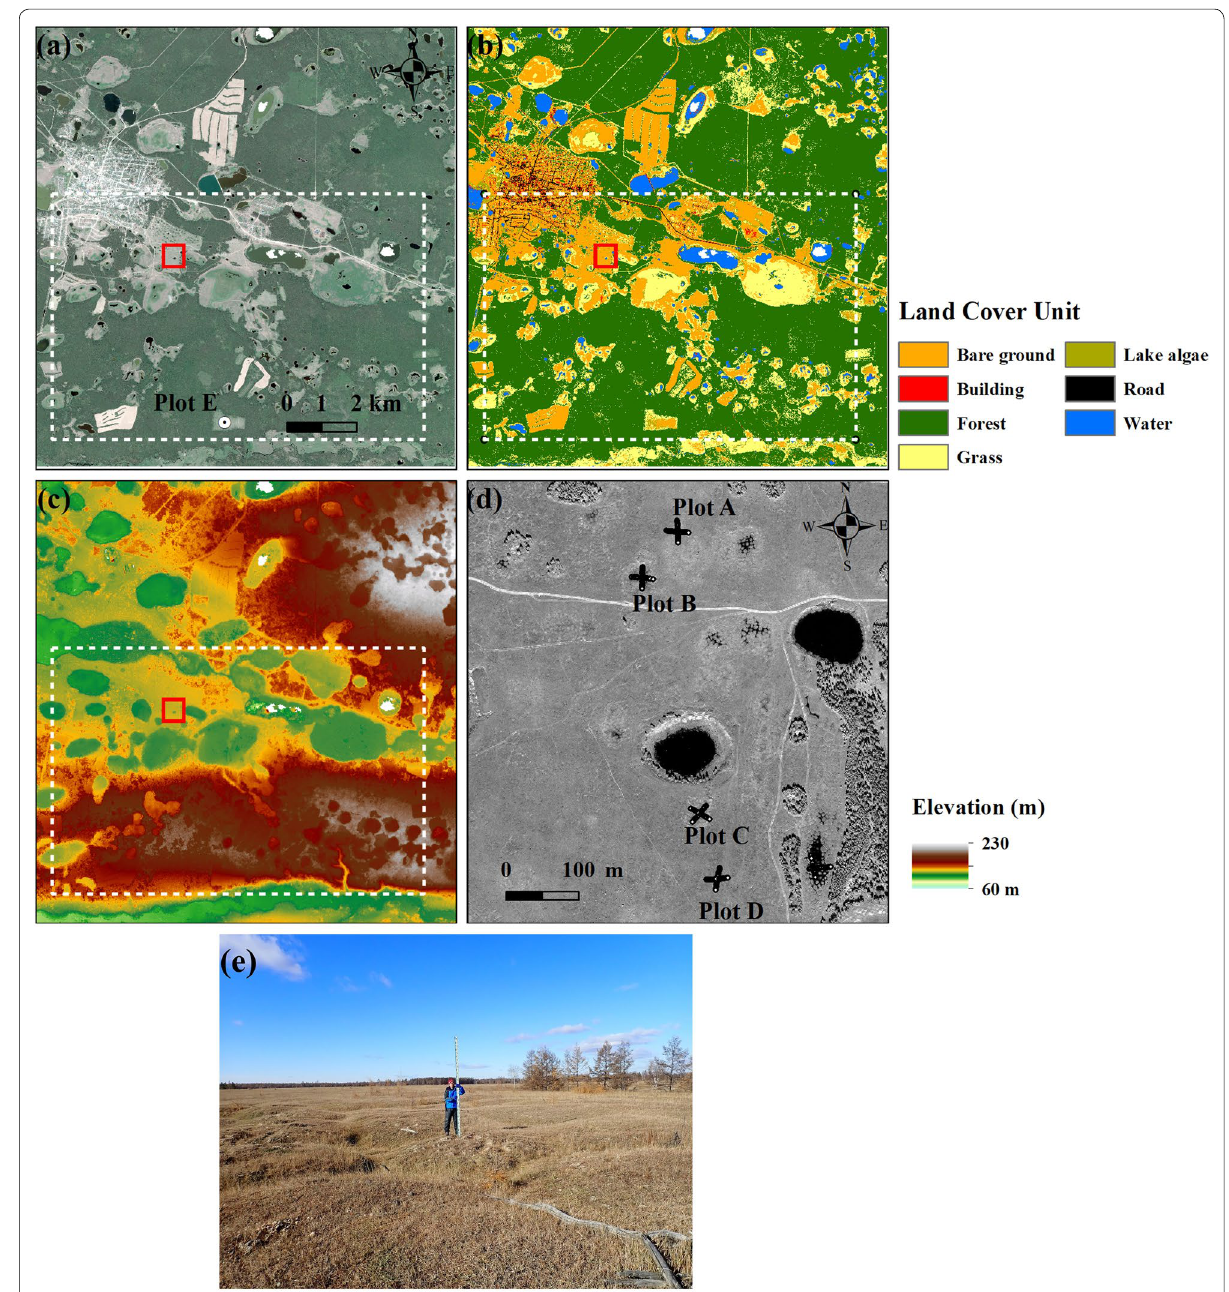
Fig. 2 a Enlarged view of Mayya using Pleiades 1B multi-spectral images taken on June 28, 2017. The red box is the area shown in ( d ). The white-dotted box is the SAR analysis area shown in Figs. 3, 4, 5, and 6. b Land cover classification. c Topography from Arctic DEM. d Area and points of the ground survey. e Photograph of the survey